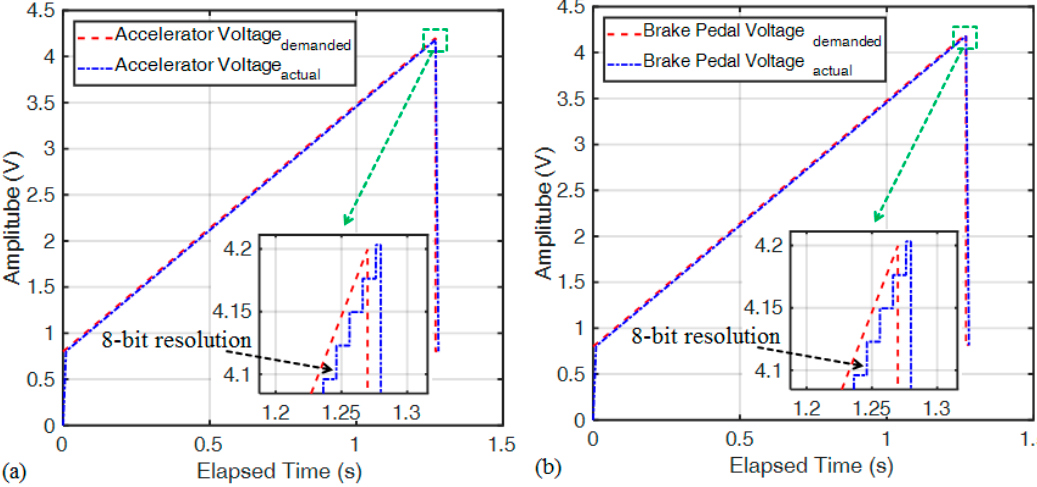
Figure 12. ( a ) The hardware configuration of steer-by-wire in a real go kart; ( b ) hardware configuration of drive-by-wire using the steering wheel, accelerator and brake pedal.